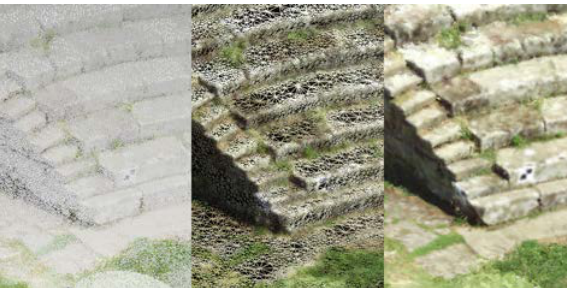
Figure 7. From point clouds (left) to mesh model (right)